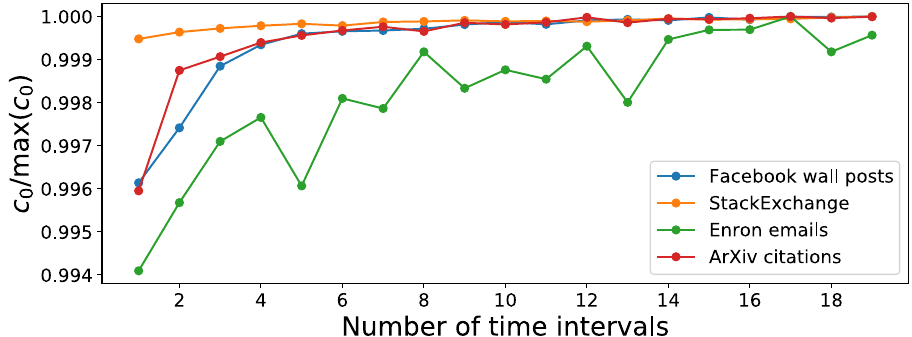
Figure 8. Likelihood ( c 0 measure) of maximum likelihood object model of the form in Eq. (11), plotted against the number of time intervals used (left) and normalised by the maximum value it